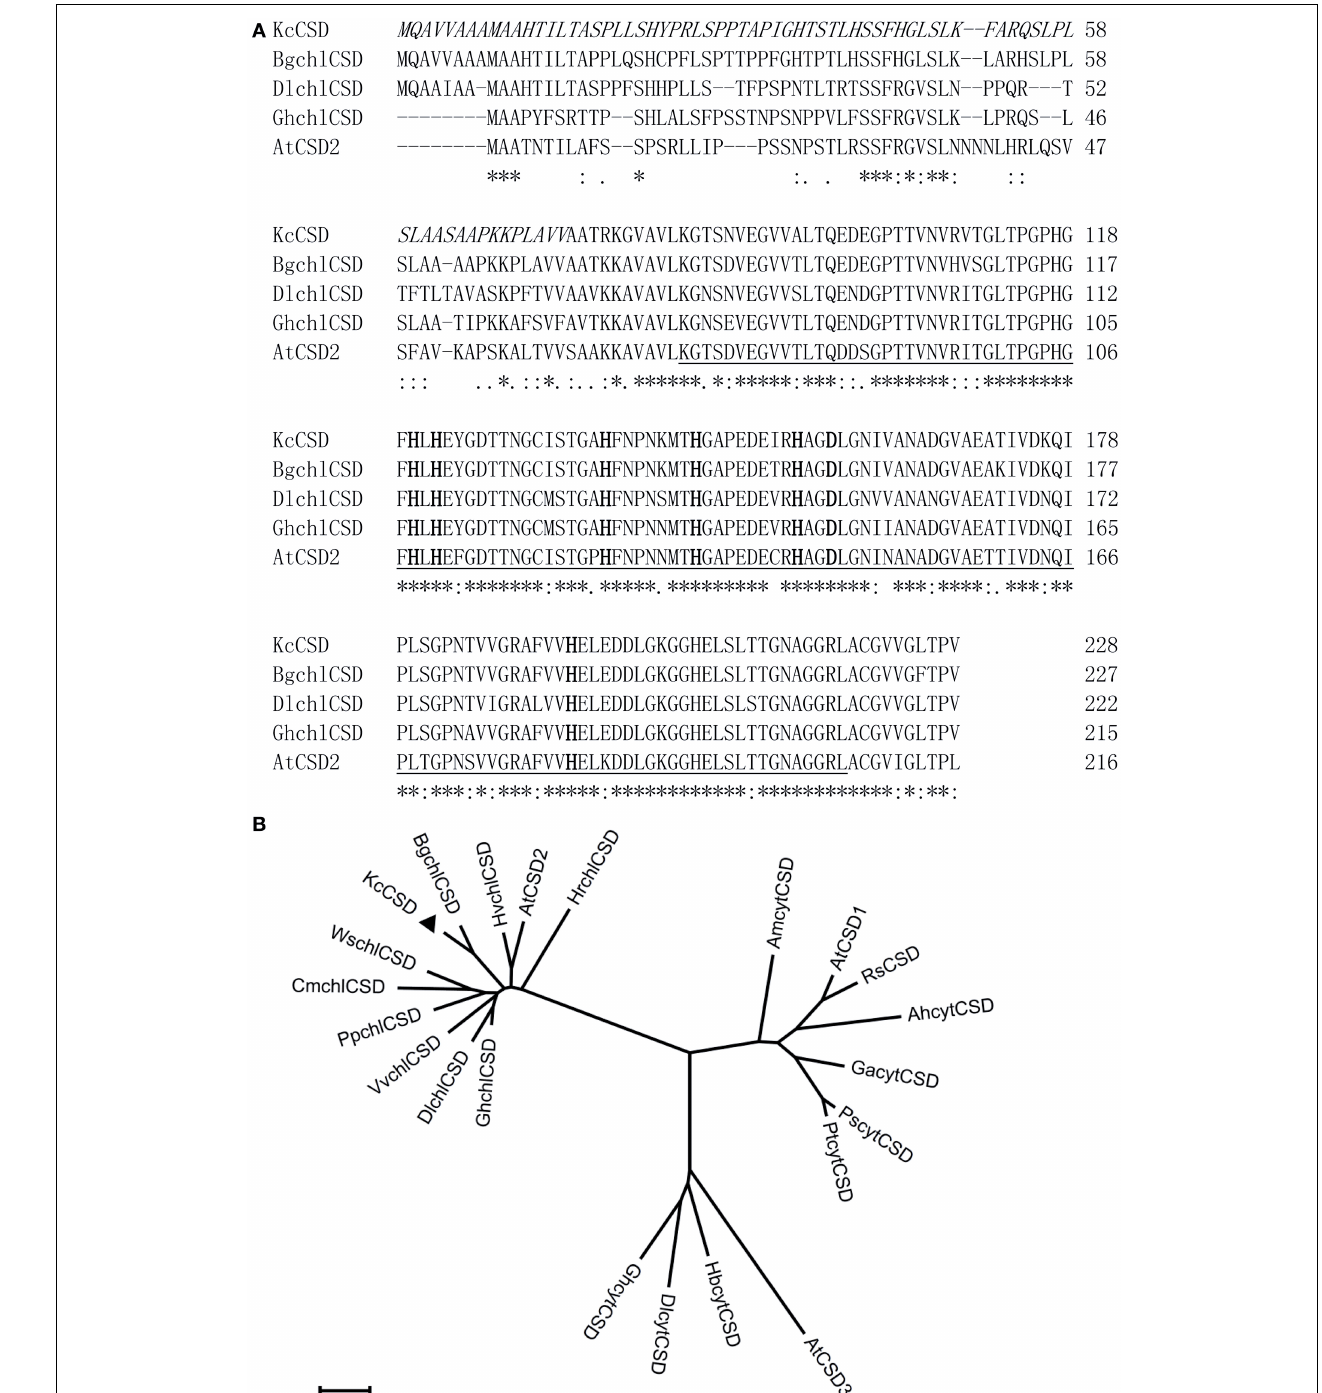
FIGURE 4 | Amino acid sequence and phylogenetic analysis of KcCSD. (A) Amino acid sequences of Cu/Zn SOD from Kandelia candle (KcCSD), Bruguiera gymnorrhiza (BgchlCSD), Dimocarpus longan (DlchlCSD), Gossypium hirsutum chloroplast (GhchlCSD), and Arabidopsis thaliana chloroplast (AtCSD2). Asterisks ( ∗ ) and dots ( · , :) indicate identical and conserved amino acid residues, respectively. Italics are chloroplast transit peptide. Bolds indicate the conserved Cu 2 + or Zn 2 + binding site. Activity sites are underlined. (B) Neighbor-joined phylogenetic tree for CSD protein sequence (chloroplast CSDs with no chloroplast transit peptides)